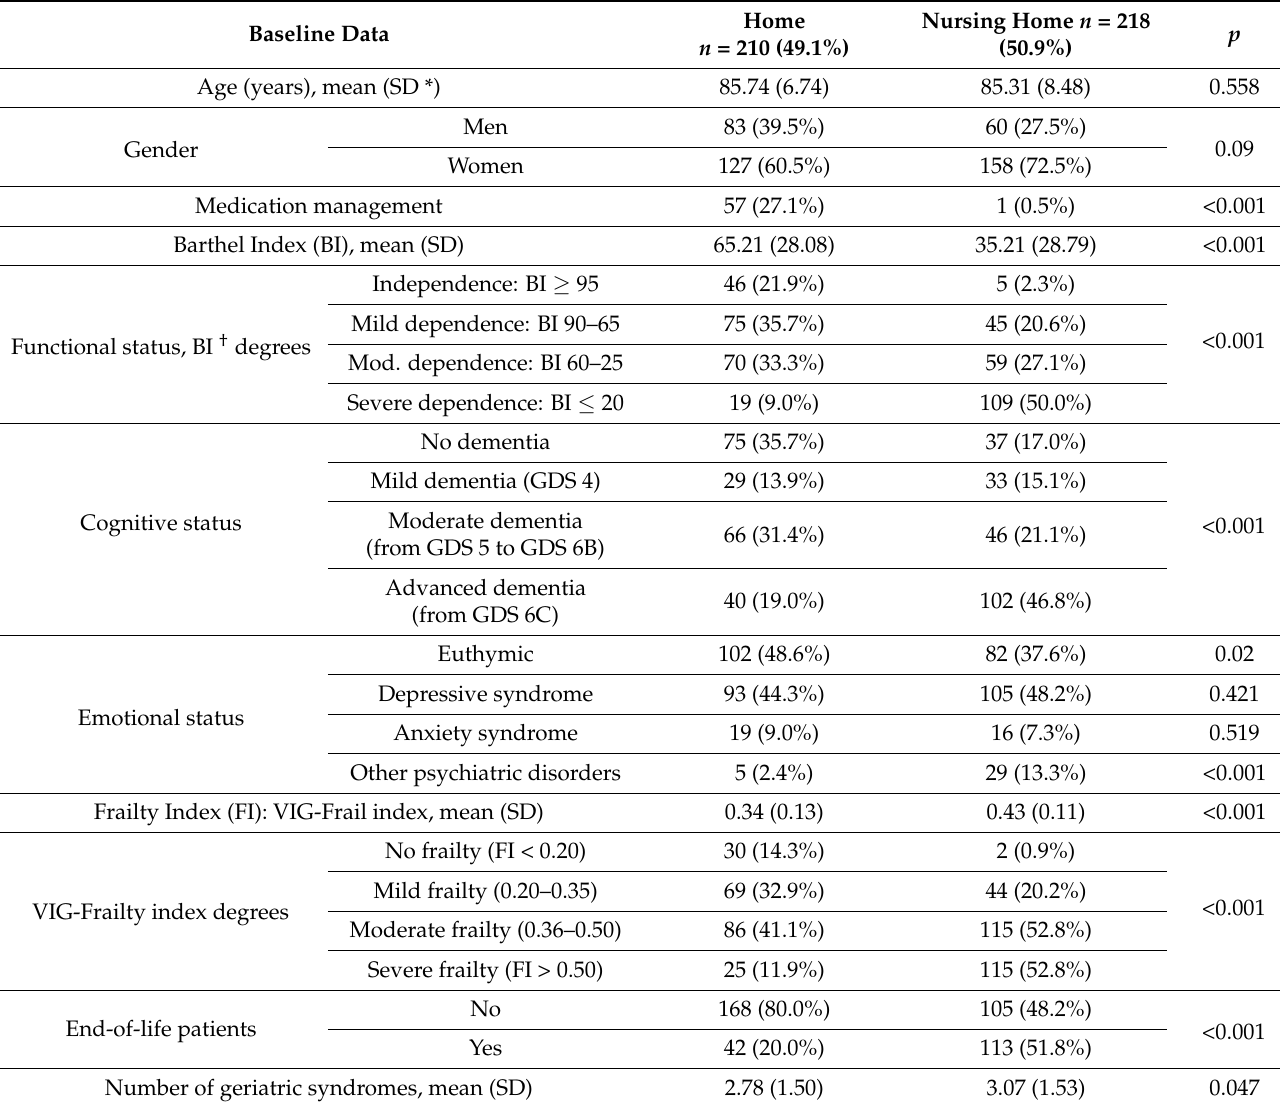
Table 2. COP-cohort’s baseline data according to their place of